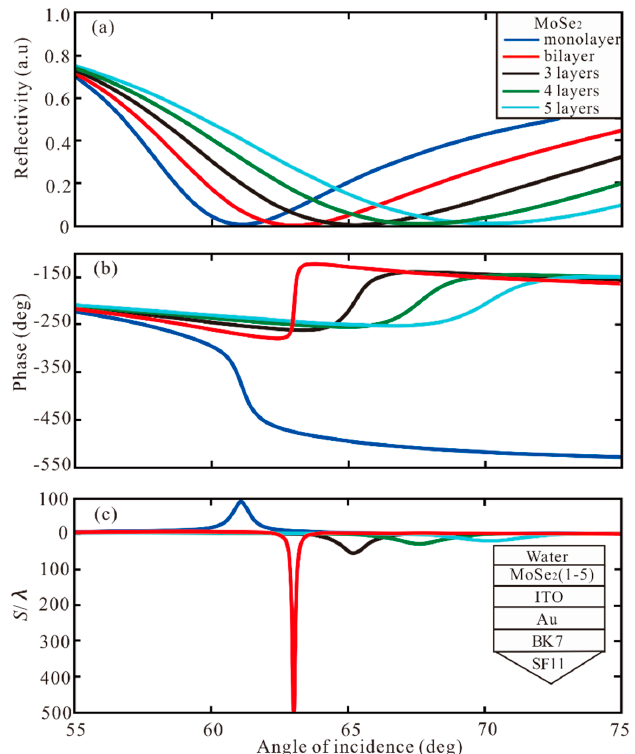
Figure 4. The change of ( a ) reflectivity, ( b ) phase, and ( c ) GH shift with respect to angle of incidence for different number of MoSe 2 layers. Sensors 2020 , 20 , x FOR PEER REVIEW